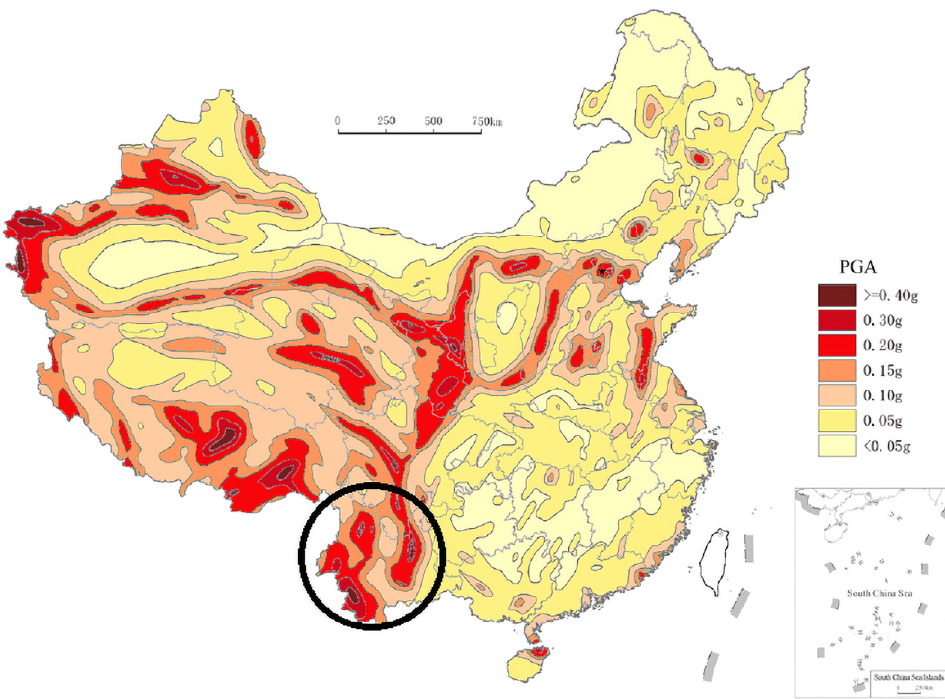
Figure 1. Seismic ground motion parameter zonation map of China (cited from the China Earthquake Administration GB18306 − 2001, China Standard Press).